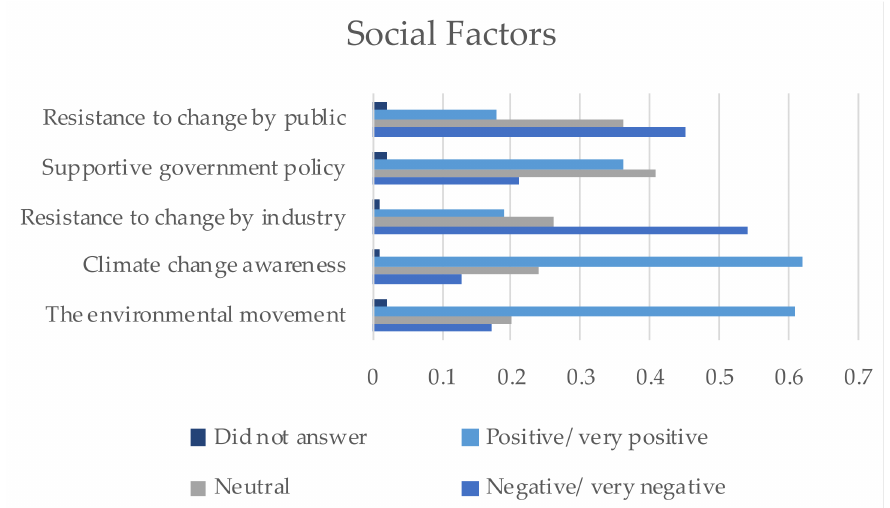
Figure 8. Responses to the question ‘What impact do the following social factors have on the adoption of timber in multi-storey projects in